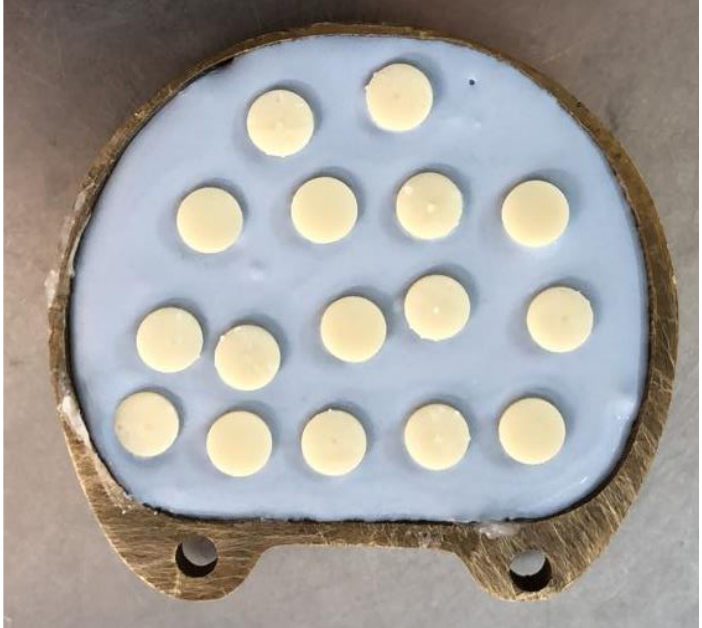
Figure 3. Wax patterns for fabricating specimens using the conventional compression-molding technique.